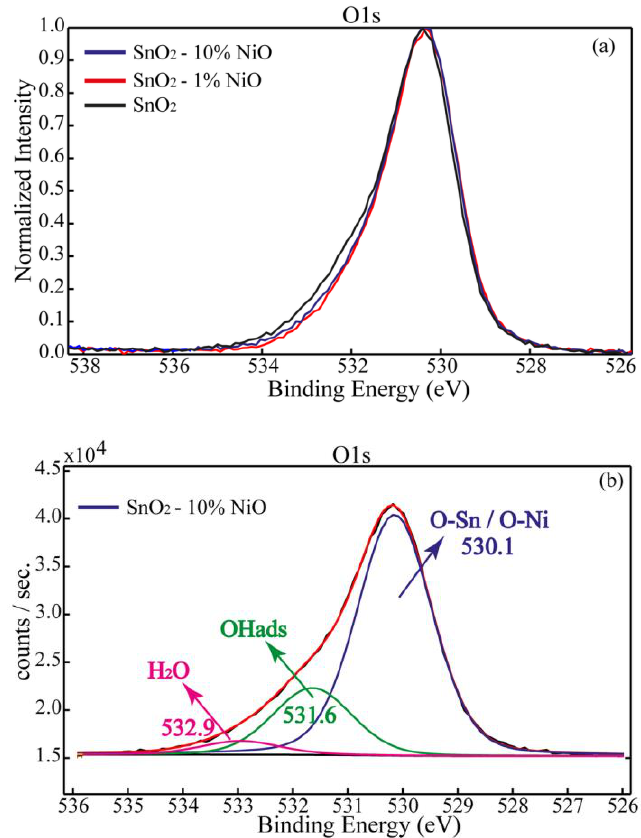
Figure 7. O1s superimposed spectra for SnO 2 , SnO 2 -1%NiO and SnO 2 -10%NiO ( a ) and O1s decon- voluted spectrum for SnO 2 -10%NiO ( b ).